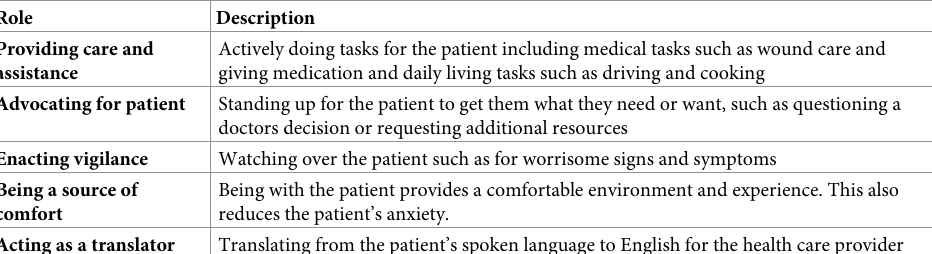
Table 3. Caregiving roles and